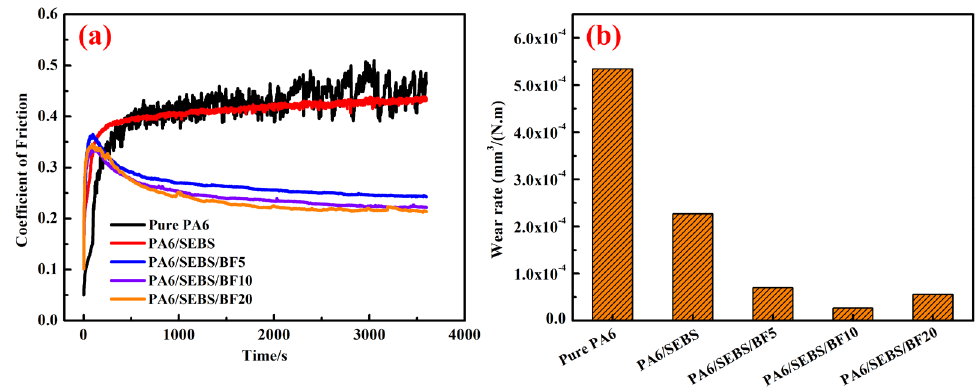
Figure 6. ( a ) The coefficient of friction and ( b ) wear rate of neat PA 6, PA 6/SEBS blend, and PA 6/SEBS/BF composites .